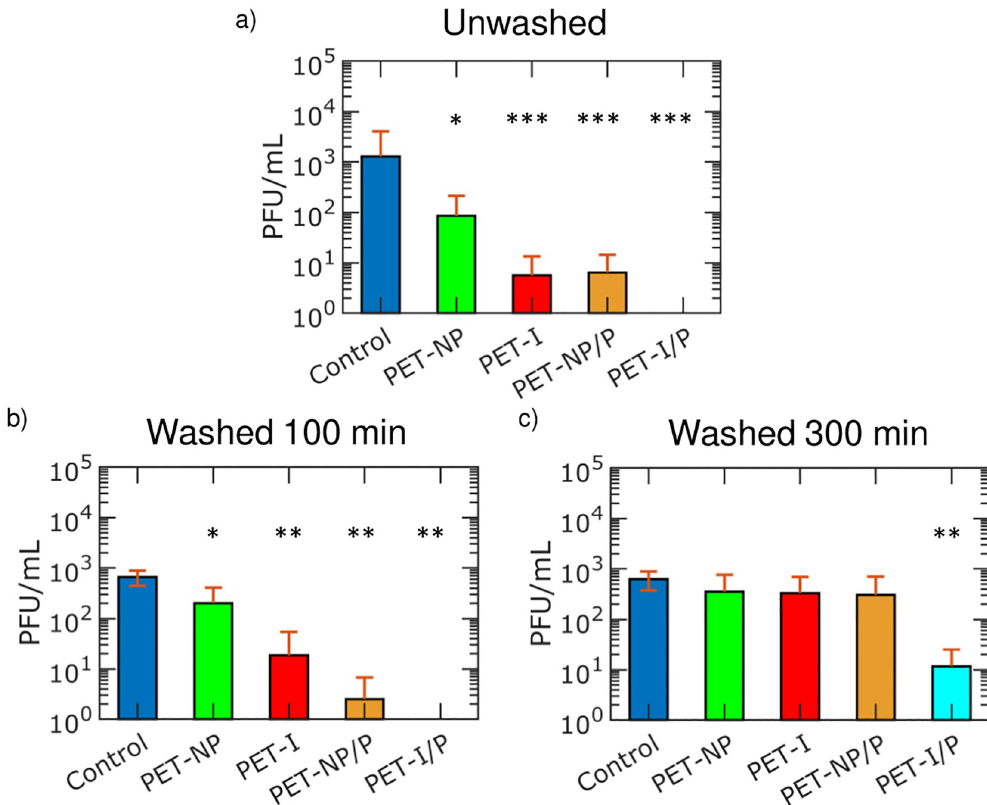
Fig 5. Antiviral comparison of treated fabrics before and after bleach washing. a) HSV-1 viral quantities for unwashed fabric samples b) HSV-1 viral quantities for fabric samples after 100 minutes of bleach ultrasonic washing c) HSV-1 viral quantities for fabric samples after 300 minutes of bleach ultrasonic